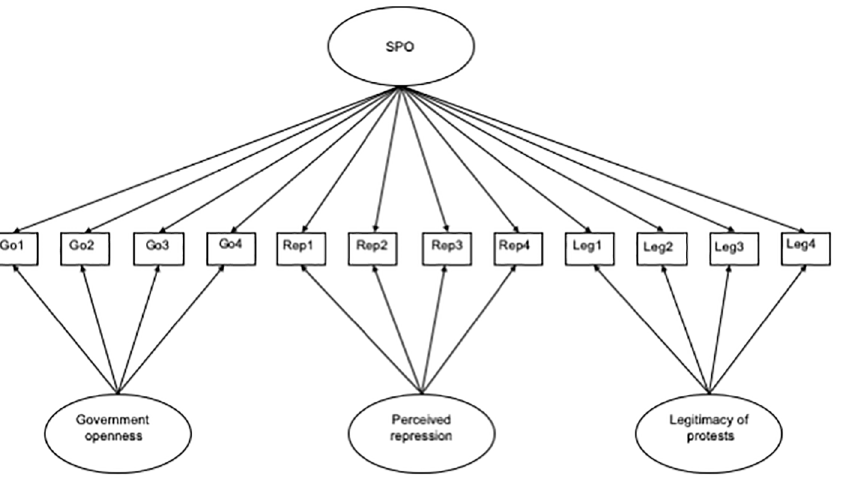
Figure 1. Original bifactor model (1 general factor + 3